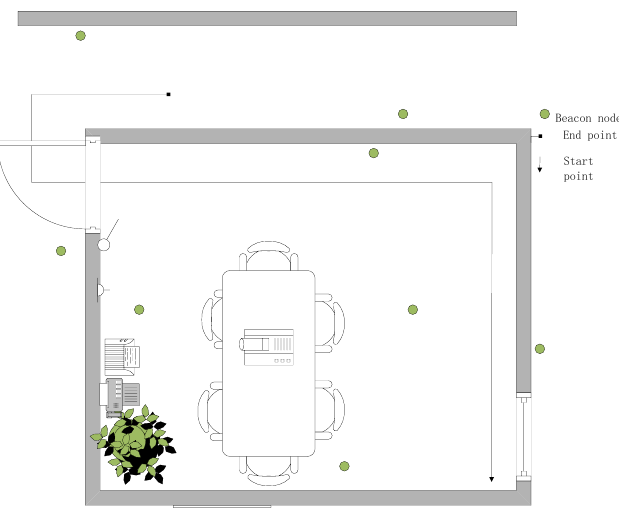
Figure 11. The experimental scene.